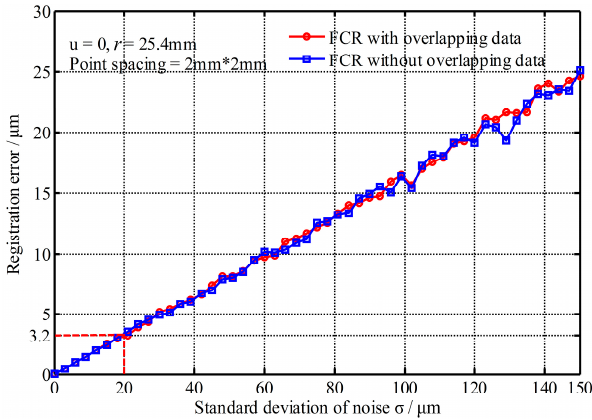
Figure 7. Registration errors changed with the standard deviation of noise.